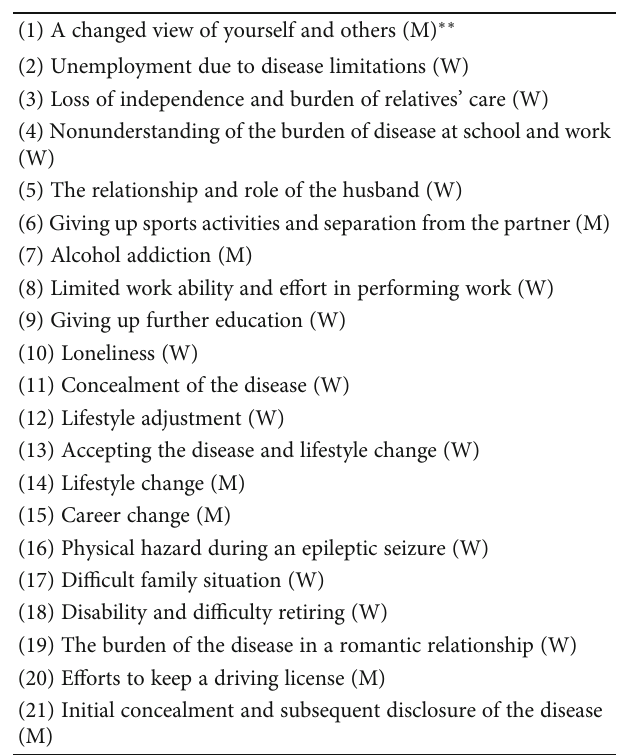
Table 2: Determined stem narratives.